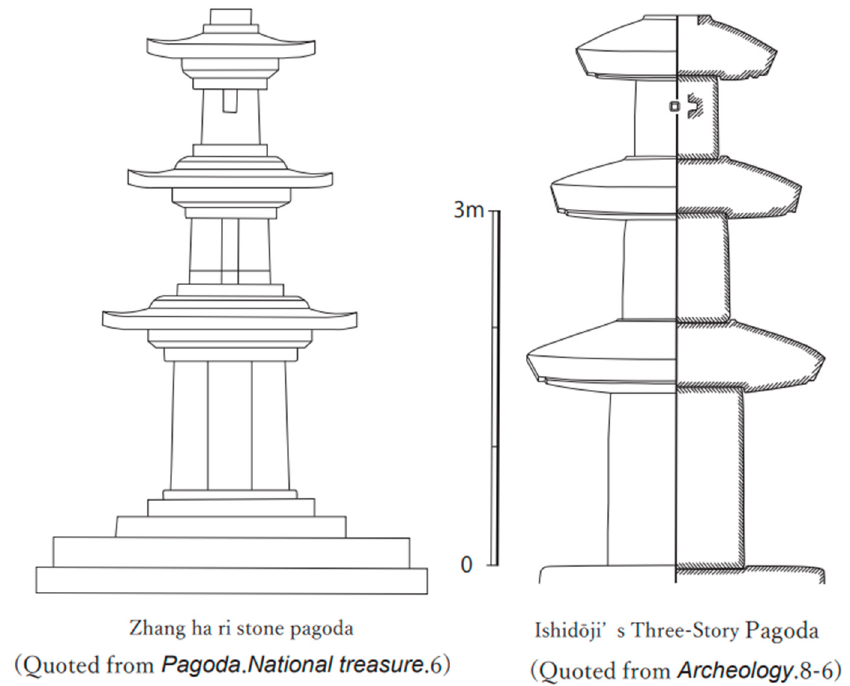
Figure 1. Morphological comparison of Zang ha ri Pagoda and Ishid ō ji Pagoda.